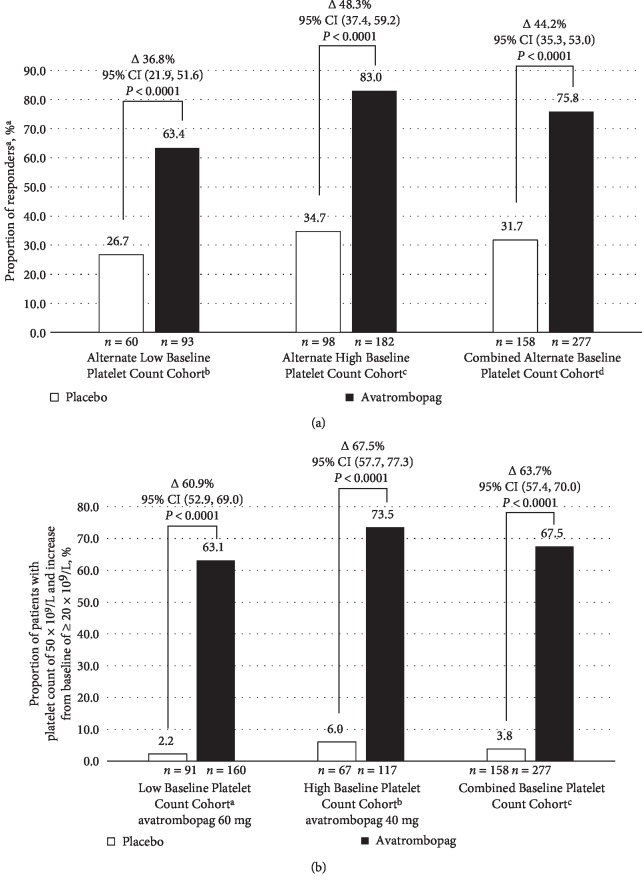
(a) Alternate Baseline Platelet Count Cohorts—Proportion of patients not requiring a platelet transfusion or rescue procedure for bleeding—Pooled data from ADAPT-1 and ADAPT-2 (Full analysis set). aResponders were defined as patients not requiring a platelet transfusion or any rescue procedure for bleeding after randomization and up to 7 days following a scheduled procedure. bAlternate Low Baseline Platelet Count Cohort included patients with a platelet count of <35 × 109/L. cAlternate High Baseline Platelet Count Cohort included patients with a platelet count of 35 to ≤50 × 109/L. dCombined Baseline Platelet Count Cohort included patients with a platelet count of <50 × 109/L. ∆ value represents the difference of proportion versus placebo = proportion of Responders for avatrombopag minus the proportion of Responders for placebo. P-value is based on Cochran–Mantel–Haenszel Test stratified by the risk of bleeding associated with the scheduled procedure. CI = confidence interval. (b) Alternate secondary efficacy endpoint analysis—Summary of proportion of patients that achieved platelet count ≥50 × 109/L and an increase of ≥20 × 109/L on Procedure Day—Pooled data from ADAPT-1 and ADAPT-2 (Full Analysis Set). aLow Baseline Platelet Count Cohort included patients with a platelet count of <40 × 109/L. bHigh Baseline Platelet Count Cohort included patients with a platelet count of ≥40 to <50 × 109/L. cCombined Baseline Platelet Count Cohort included patients with a platelet count of <50 × 109/L. ∆ value represents the difference of proportion versus placebo = proportion for avatrombopag minus the proportion for placebo. 95% CI is calculated based on normal approximation. P-value is based on Cochran–Mantel–Haenszel test stratified by the risk of bleeding associated with the scheduled procedure. CI = confidence interval.